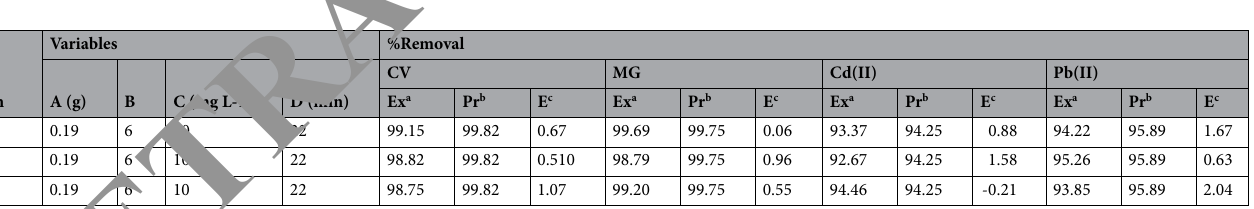
Table 2. Optimum conditions of removal of CV, MG, Cd(II) and Pb(II). a Experimental, b Predicted, c